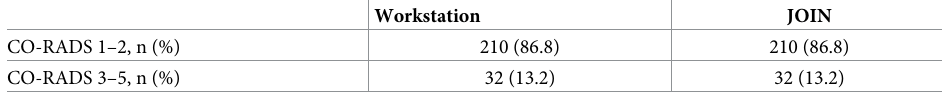
Table 3. Intrarater agreement for the evaluation of COVID-19 lung involvement in workstations and